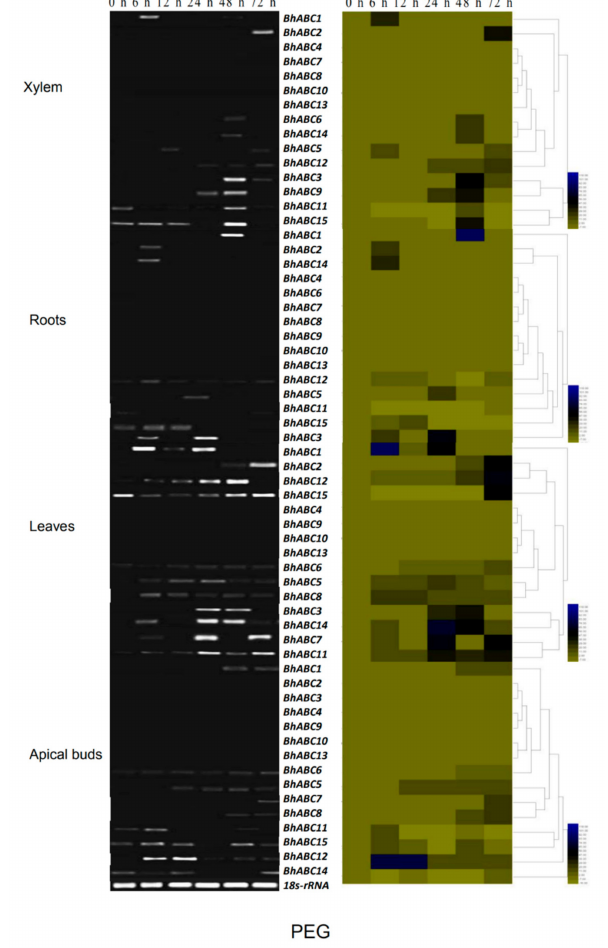
Figure 13. Expression patterns of BhABC genes in xylem, roots, leaves, and apical buds after PEG treatment. Heat map showing responses of BhABC genes to PEG (right); semi-quantitative RT-PCR analysis with 18s RNA internal reference